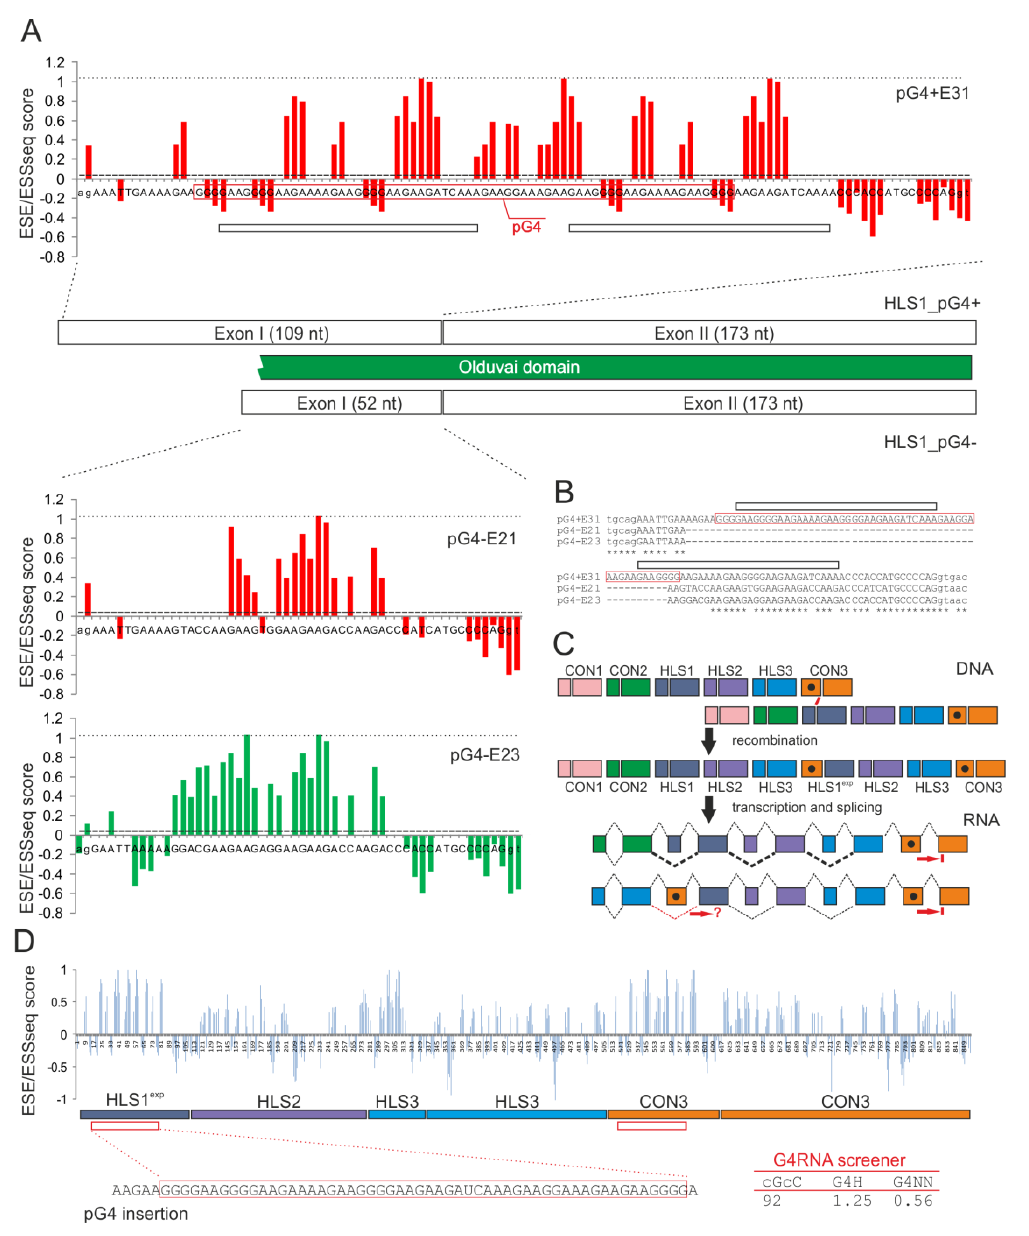
Figure 1. Splicing enhancer activities of the first exon in expanded and unexpanded Olduvai doublets and RNA G4 predictions. ( A ) ESE/ESSseq scores for overlapping hexamers in representative pG4-containing (pG4+, top panel ) and pG4-lacking (pG4-, bottom panel ) NBPF10 exons. Exon (E) numbers correspond to the longest transcripts, with E21 and E23 representing examples of HLS sub-types with unexpanded first exons of the Olduvai doublet and E31 representing the expanded version. Horizontal dotted lines at the top of each chart denote the maximum ESE/ESSseq values (1.034 for the strongest splicing hexamer AGAAGA, ref. [8]). The horizontal dashed line shows mean values for control human exons [9]. Horizontal black boxes at the top panel denote duplicated regions in the expanded first exons of Olduvai doublets. The 68 nt pG4 sequence [6] is in a red box. ( B ) The alignment of the NBPF10 exons that contain (+) or lack (−) pG4. Exonic sequences are in upper case and flanking intronic sequences are in lower case. pG4 is in a red box; black boxes denote duplicated regions. ( C ) Predicted effects of Olduvai exon expansions on RNA processing. Top , non-homologous allelic recombination was previously proposed to explain Olduvai amplifications [6]. Black dots denote pG4 sequences, red line denotes the location of an intron recombination breakpoint [6]. exp , expanded Olduvai sub-type. Bottom , the putative impact of